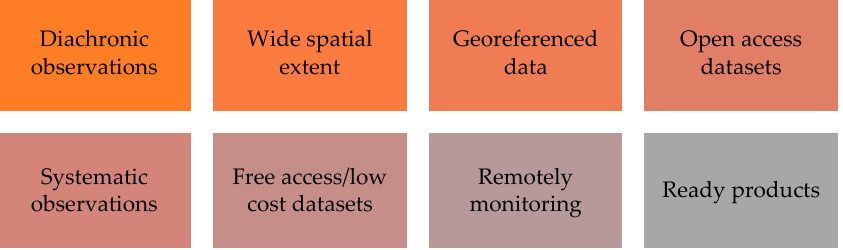
Figure 5. Favorable characteristics of satellite observation datasets for DRM of cultural heritage.